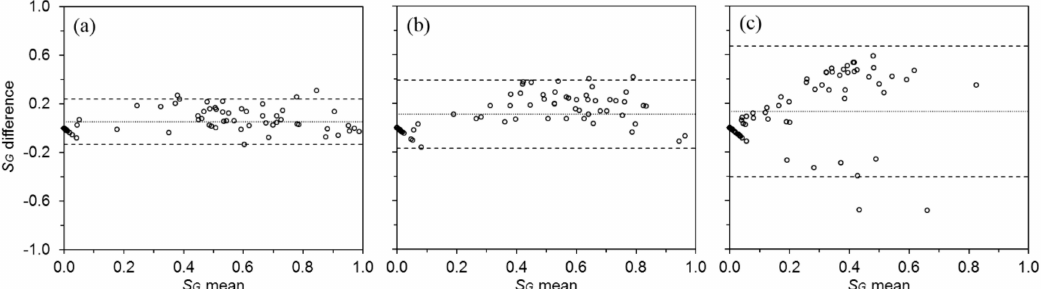
Figure 5. Bland and Altman plots for the sparkle grade ( S G ) at the three sparkle geometries: ( a ) − 15 ◦ x: 0 ◦ , ( b ) 45 ◦ x: 0 ◦ and ( c ) 75 ◦ x: 0 ◦ . Dashed lines indicate the 95% limits of agreement and dotted